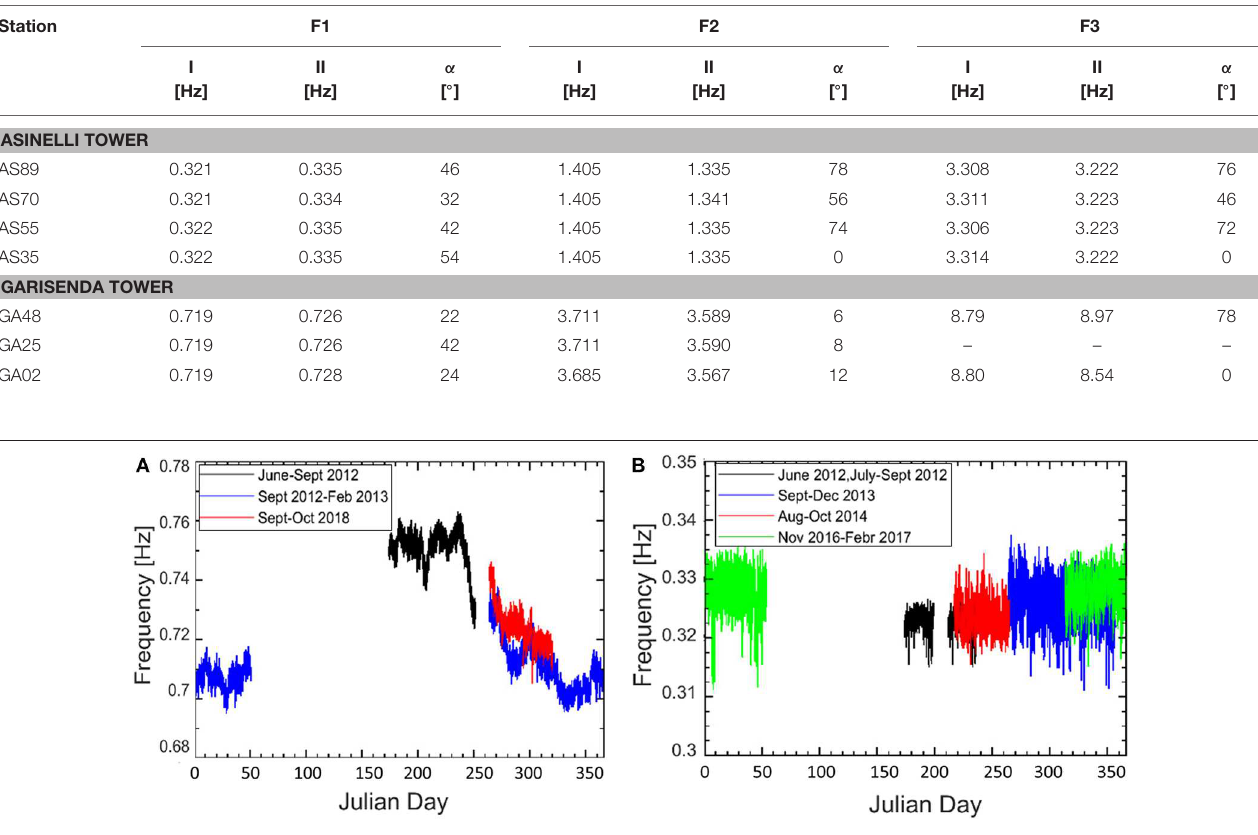
FIGURE 4 | Seasonal trend of the fundamental frequency along EW direction. (A) Garisenda Tower and (B) Asinelli Tower.